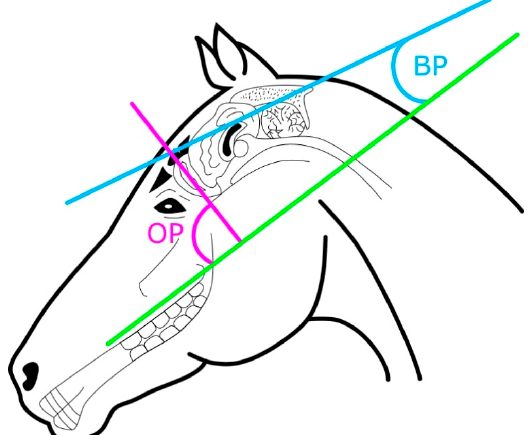
Figure 2. Diagram of brain measurements on horse ( n = 14) and donkey ( n = 16) skulls. The olfactory pitch (OP) was measured as the angle between the hard palate (green line) and the longitudinal axis of the olfactory bulb (purple line). The brain pitch (BP) was measured as the angle between the hard palate and the longitudinal axis of the brain (blue line).